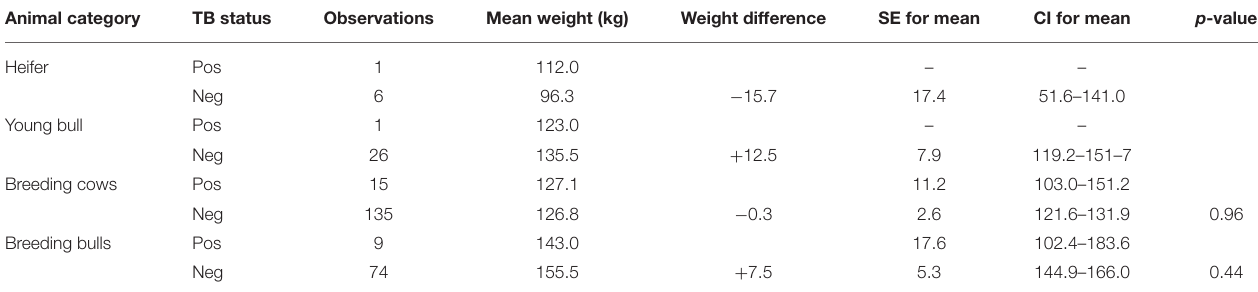
TABLE 4 | TB status and carcass weight among 267 animals (based on visible TB-like lesions). Animal